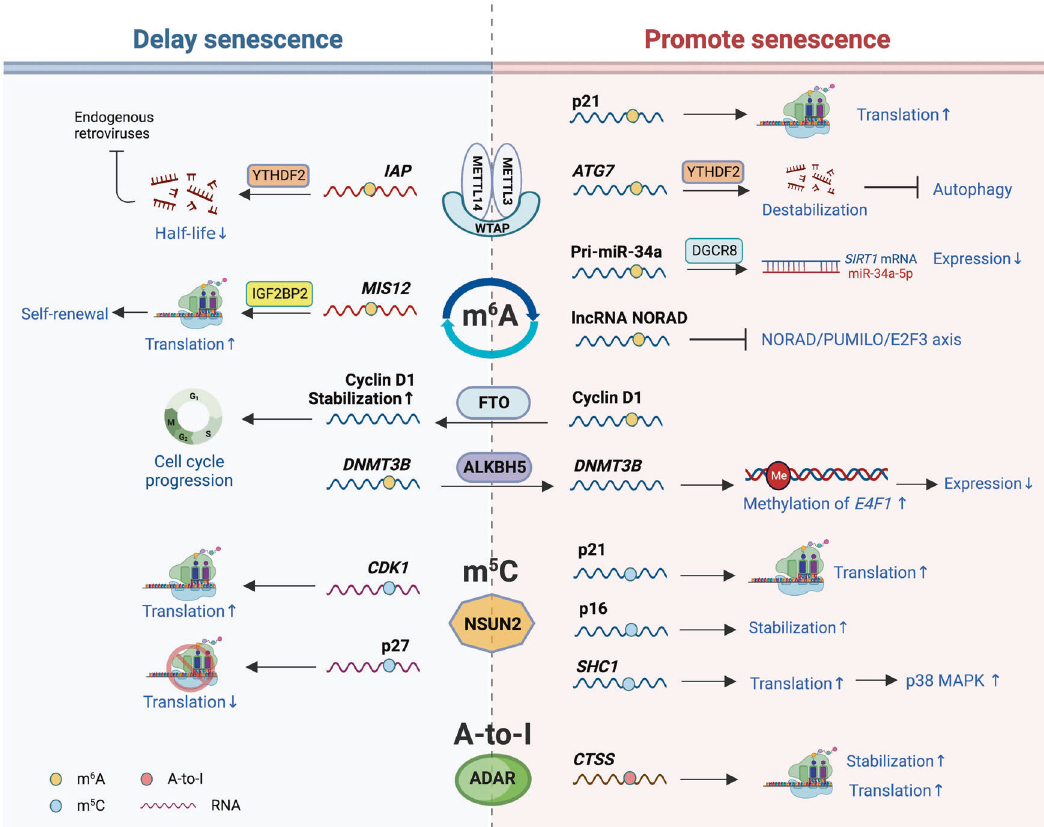
Fig. 5 RNA modi fi cations involved in senescence. RNA modi fi cations that have been revealed to be associated with senescence or aging mainly include m 6 A modi fi cation, m 5 C modi fi cation, and adenosine-to-inosine (A-to-I) editing. The m 6 A modi fi cation is regulated by factors including the writer RNA methyltransferases complex, the erasers FTO and ALKBH5, and the reader YTHDF2, whose effects on senescence are complex based on different substrates. Under different stress conditions, m 5 C modi fi cation mediated by NSUN2 plays opposite roles in senescence, retarding replicative senescence and accelerating oxidative-induced senescence. The A-to-I RNA editing catalyzed by the ADAR family mainly exists in the central nervous system, and its relationship to neurodegenerative diseases has been